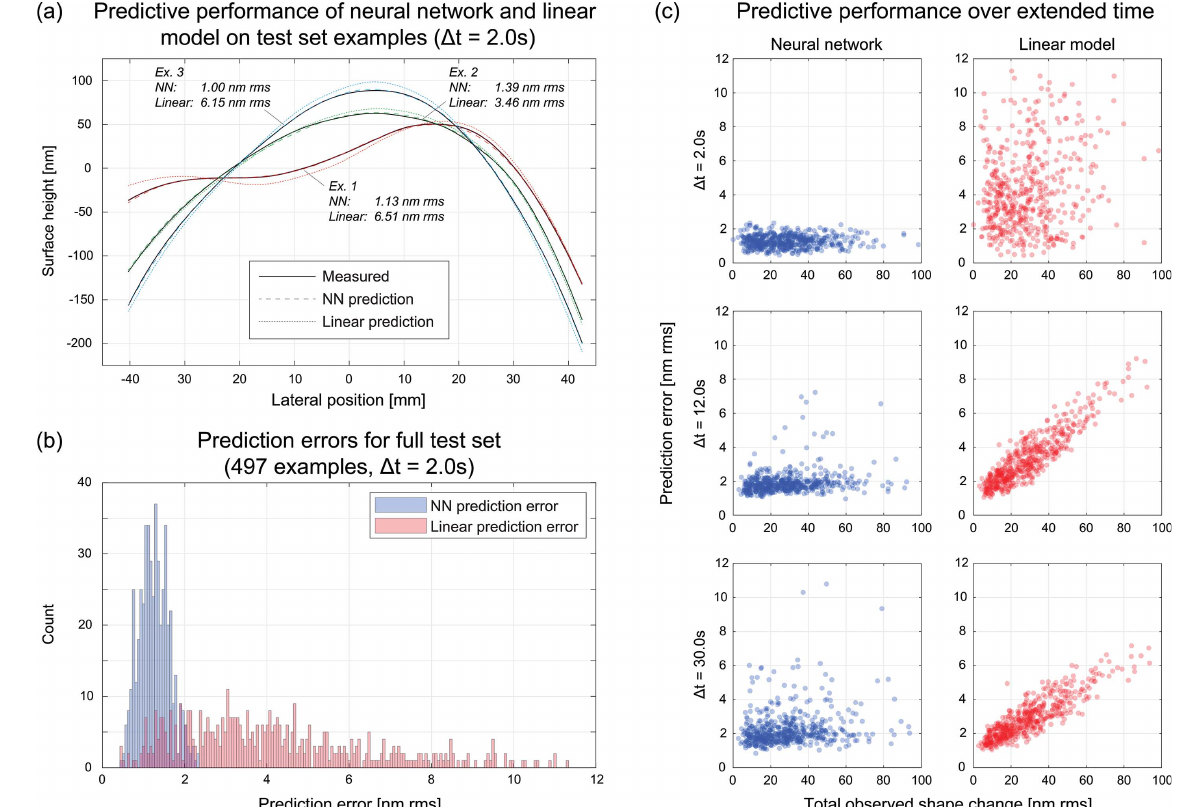
Figure 3 Performance of predictive model on test data. ( a ) Predicted curves from the neural network and linear models for three examples in the test dataset. ( b ) Predictive performance of neural network and linear models across a full test dataset. ( c ) Prediction errors of neural network and linear models plotted against the observed RMS change in surface shape for three different time scales. For time scales larger than 2 s, the neural network model is iteratively